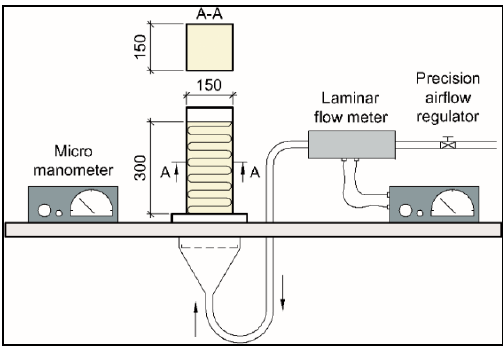
Figure 1. Principle of the apparatus used to measure the air permeability of the insulation material samples. The units for the numbers in the figure are mm.